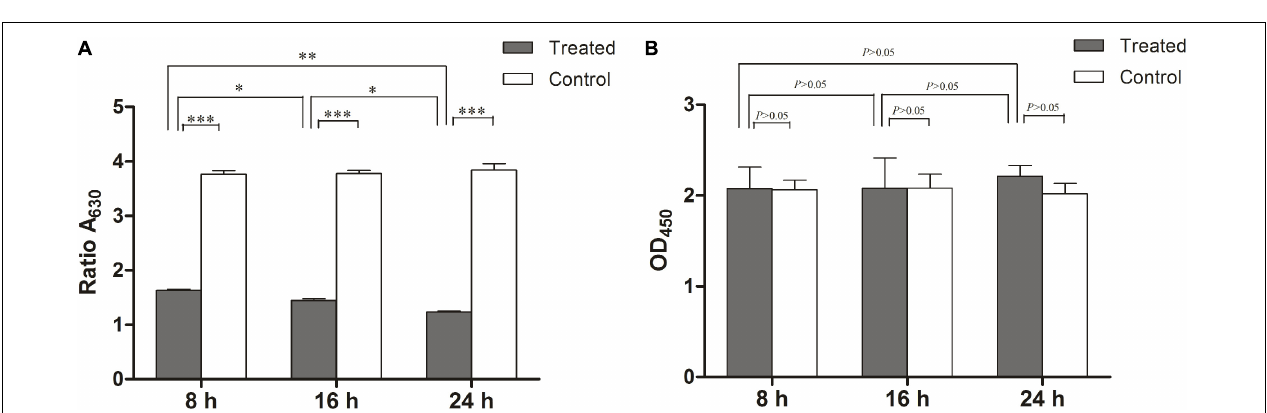
FIGURE 3 | TEM micrograph showing the four changing stages of mesosome-like structures of L. monocytogenes planktonic cell after treated with linalool. The red circles indicated the mesosome-like structures.